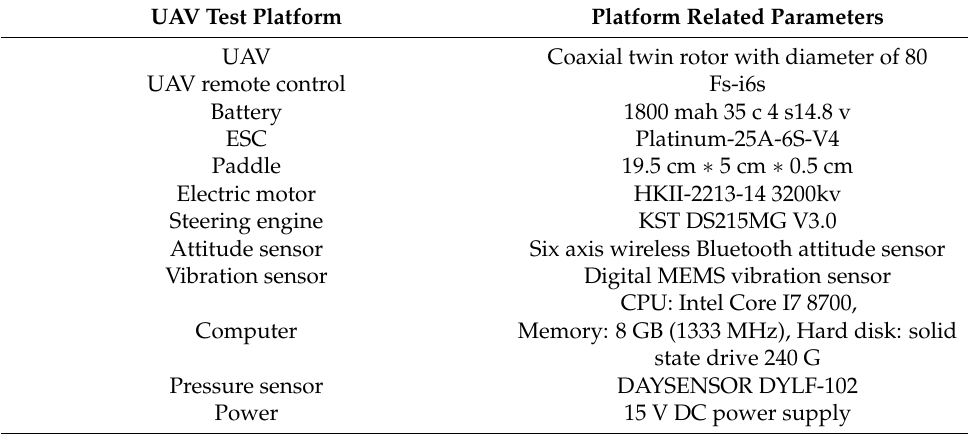
Table 1. Table of relevant parameters of the UAV and UAV test